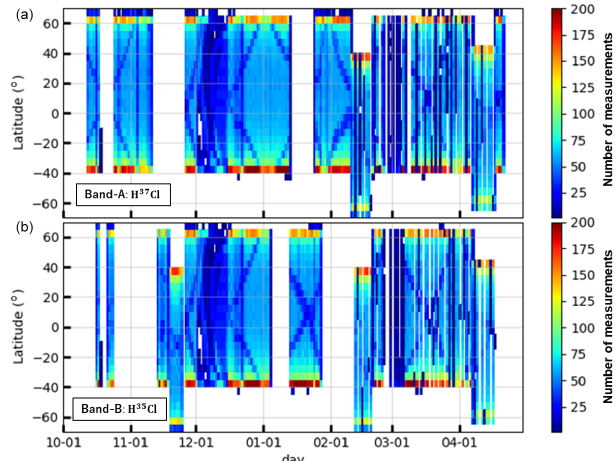
Figure 1. Number of HCl observations for a 5 ◦ latitude bin in 1d for the range of SMILES observational latitudes and period (12 Oc- tober 2009–21 April 2010). Panels (a) and (b) show the number of observations from band A (H 37 Cl) and band B (H 35 Cl), respec-